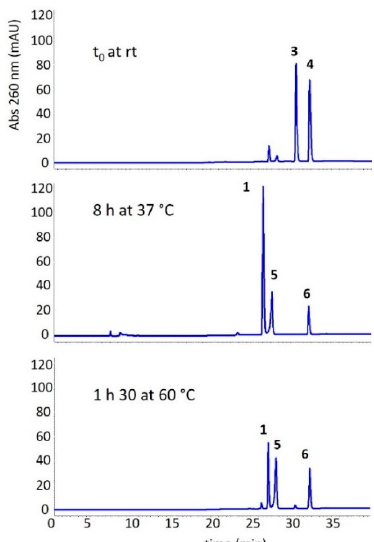
Figure 9. HPLC analysis of the transformation of oxaziridines 3 and 4 back to 1 in the dark. Upper trace, at t0 the mixture of 3 and 4 at Rt = 30 min and 32 min, respectively. Middle trace, 1 (Rt = 26 min) is the major product. It is associated with the aldehyde derivative (5) (Rt = 27 min) and the amide derivative (6) (Rt = 32 min). Lower trace, the proportion of 5 and 6 becomes more important with respect to 1 (Rt = 26 min). rt: room temperature.